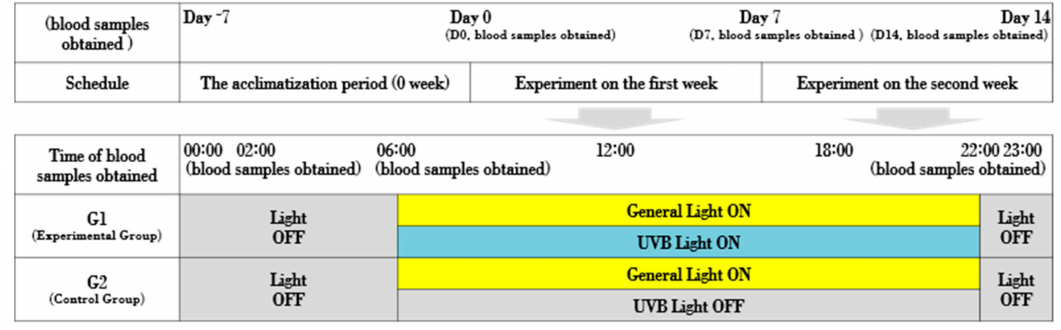
Figure 5. Animal experiment